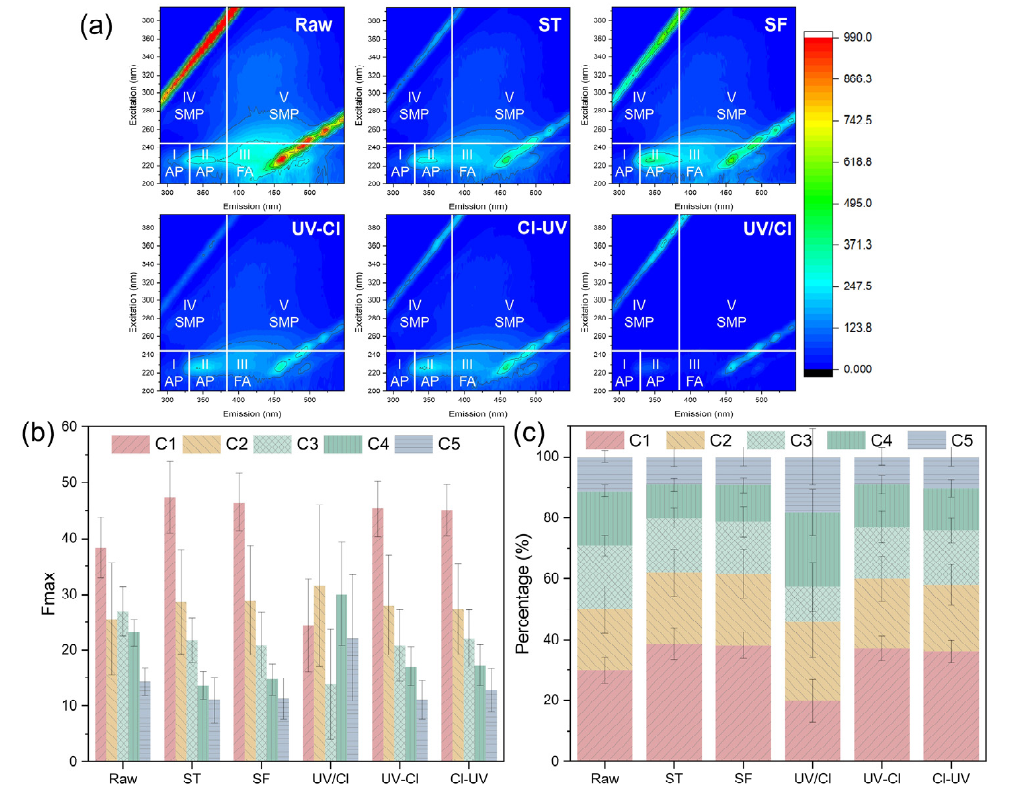
Figure 2. Change of fluorescence EEM matrix ( a ), Fmax of PARAFAC components ( b ) and ratio of PARAFAC components ( c ) in raw water (Raw), treated effluents from settling tank (ST), sand filtration (SF), UV-Cl, Cl-UV and UV/Cl.